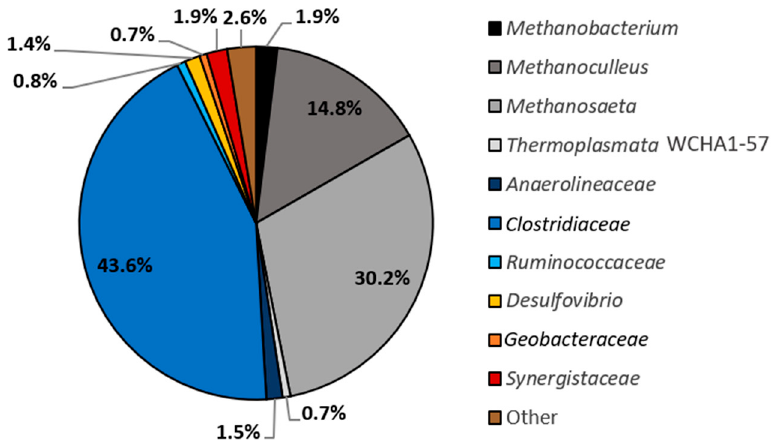
Figure 3. Distribution of bacterial and archaeal 16S rRNA gene pyrotag sequences in an active naphthalene-degrading replicate of NDC. Values are shown as the percentage of sequences per taxon based on 2034 bacterial sequences and 1881 archaeal sequences. OTUs included in ‘Other’ make up less than 0.4% of prokaryotic sequences each and include Spirochaeta (0.26%), Proteiniphilum (0.13%), and Candidatus Methanoregula (0.36%).